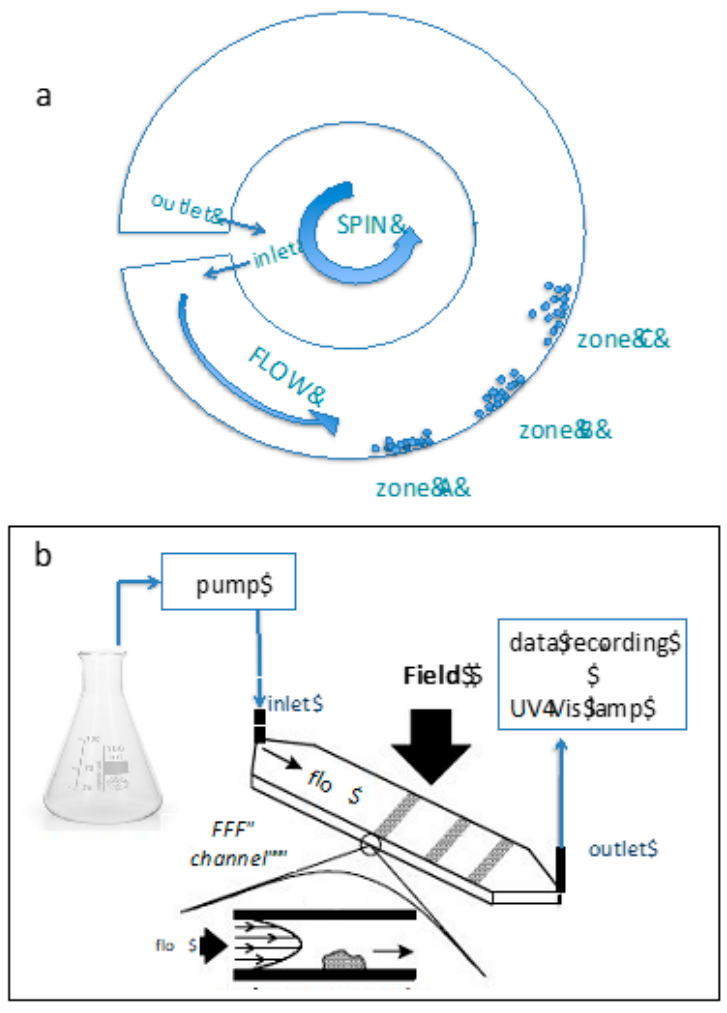
Figure 7. SdFFF operation diagram ( a ) and instrument configuration set up ( b